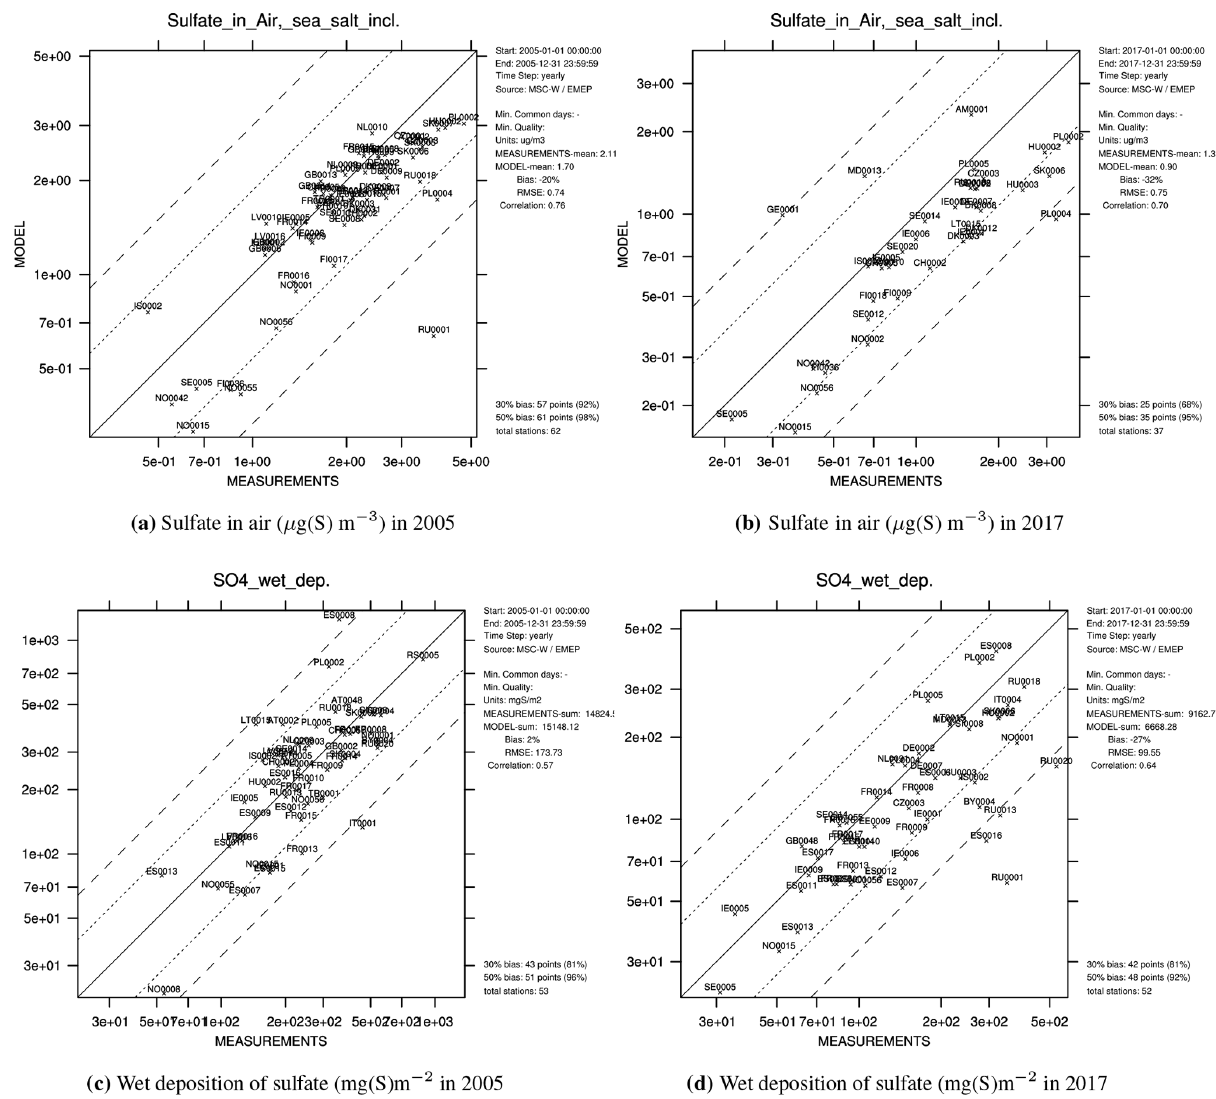
Figure A4. Scatter plots of modelled versus observed concentrations of sulfate in air (a, b) and wet deposition of sulfate (c, d) for the years 2005 (a, c) and 2017 (b, d) . Statistics with a limited set of common measurement sites are given in Table A1. Site positions are listed in Table A2. Measurements were downloaded from http://ebas.nilu.no (last access: 14 December 2021).